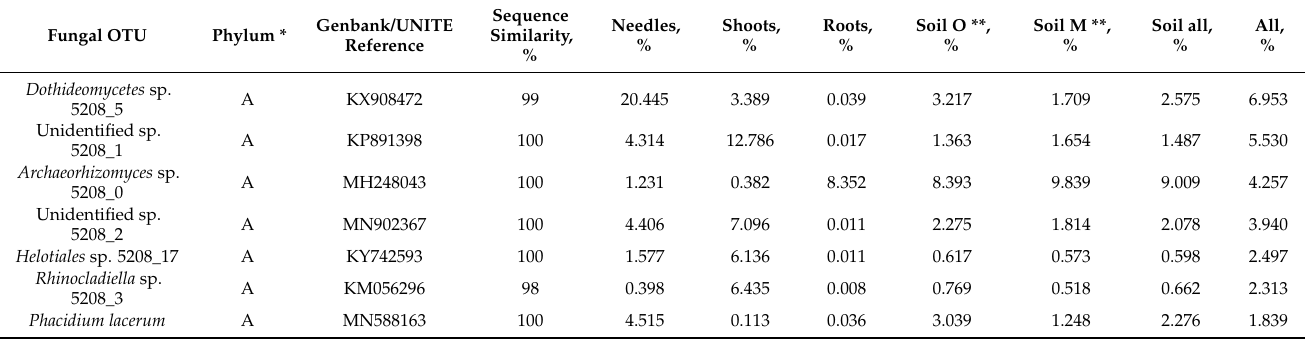
Figure 5. Relative abundance of fungal classes in needles, shoots, roots, and the soil of Pinus sylvestris . Other represented fungal classes with a relative abundance of <1%. The data from the 30 different sample sites are combined. Table 3. Relative abundance (%) of fungal OTUs associated with needles, shoots, roots, and organic and mineral soil of Pinus sylvestris . All study sites are